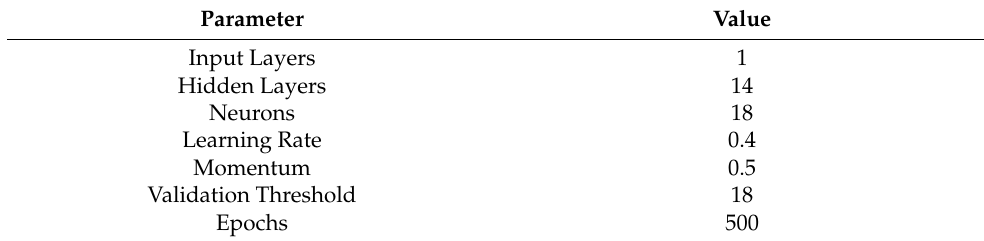
Figure 7. MLP Based classification of medicinal plant leaves framework. Table 2. Deployed MLP classifier parameters.